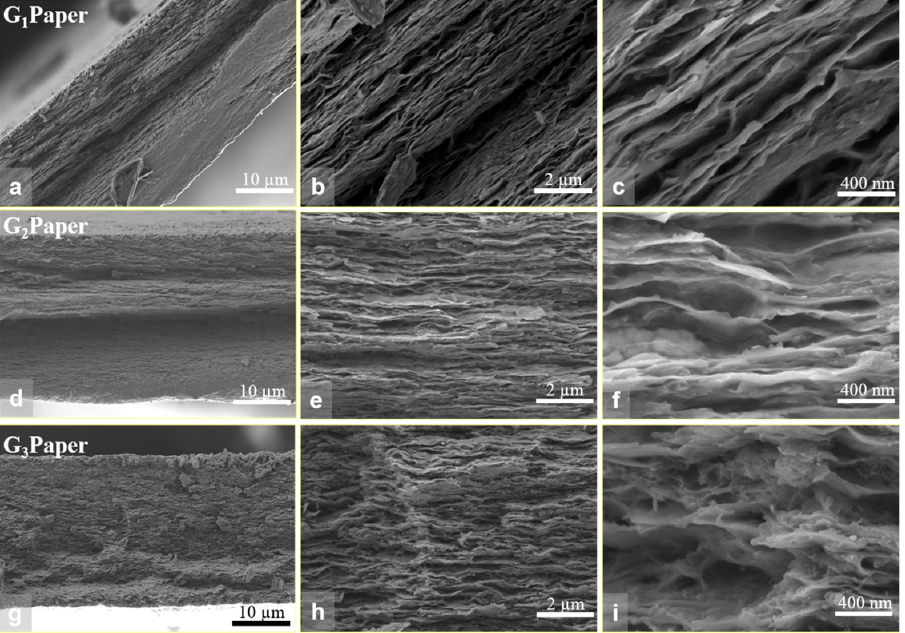
Figure 4. Morphology and structure of PEG/GONR/MMT nanocomposite papers: ( a – c ) PEG/GONR-1/MMT (G 1 ) paper; ( d – f ) PEG/GONR-2/MMT (G 2 ) paper; ( g – i ) PEG/GONR-3/MMT (G 3 ) paper, showing nacre-like layered structure.